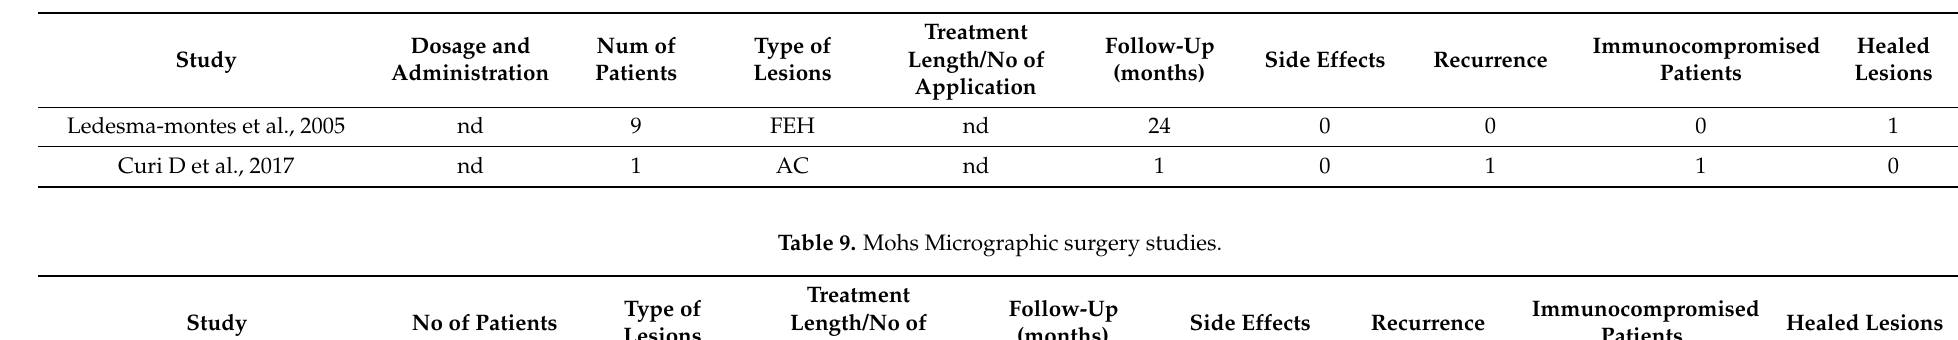
Table 8. Cryotherapy studies.